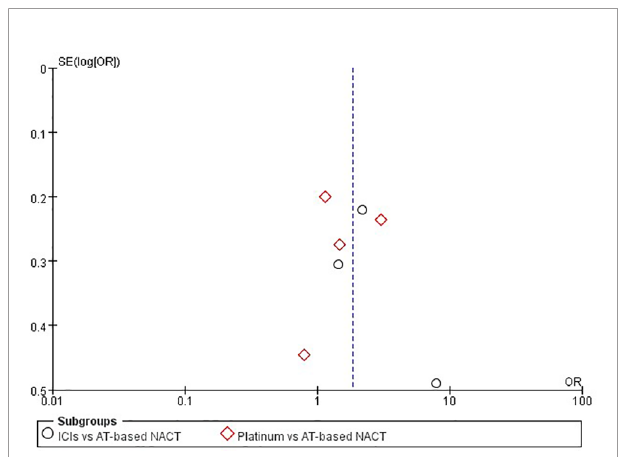
FIGURE 7 | Funnel plot assessment of publication bias for pCR in patients receiving ICIs vs AT-based NACT and platinum-based vs AT-based NACT in early TNBC patients.